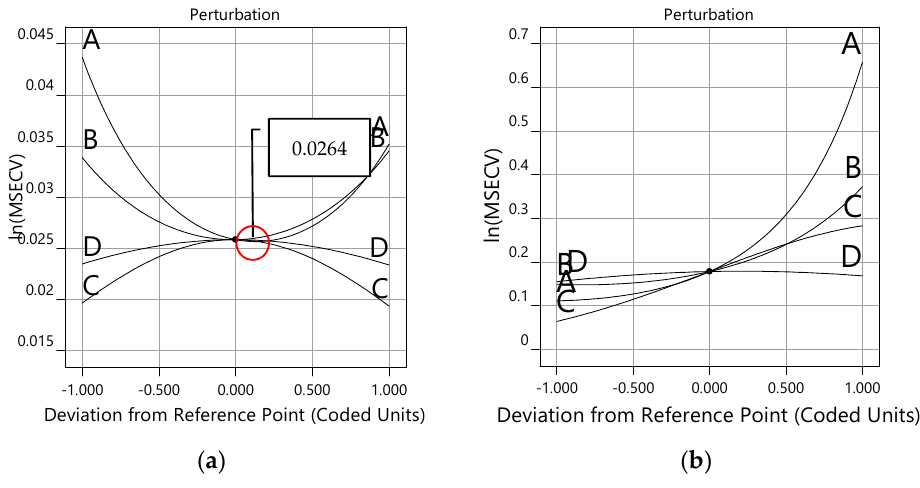
Figure 10. Perturbation plot for training functions, ( a ) trainlm and ( b ) traingdm. Notice that the optimum values of ln(MSECV) for the network parameters (A, B, C, and D) can be found at 0.0000 (coded value), as shown in Figure 10a for the lm training function and in Figure 10b for the gdm training function. In this case, the optimum values for A, B, C, and D are, respectively, 16, 0.16, 0.75, and 850, as presented in Table 6. It can be observed that both Figures 9 and 10 present similar plots of ln(MSECV), but the former plot represents the interaction graph which uses the actual value of the variables, while the latter represents the perturbation graph which uses coded values. Both graphs describe the relationship of the network parameters. As shown in Table 6, the best network parameters obtained from the conventional and proposed methods are presented for all network parameters. Therefore, the optimum values suggested by RSM were as follows: number of neurons = 16, learning rate = 0.16, momentum = 0.75, and number of epochs = 850, and trainlm has been selected as a training function. The best network parameters for FFNN-lm had minimum MSECVs when the number of neurons, the learning rate, the momentum, the number of epoch and the training function were 29, 0.7, 0.5, 300, and trainlm , respectively.